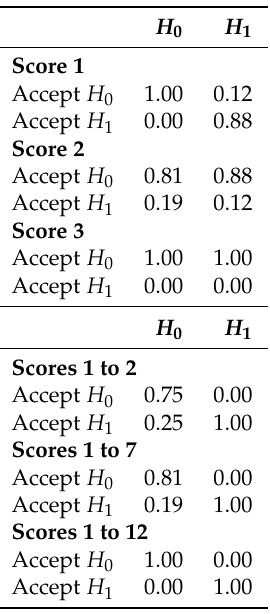
Table 7. Sensitivity and specificity of the test considering the first score, the second score, the third score (left); and scores 1 to 2 (jointly), scores 1 to 7 (jointly), and scores 1 to 12 (jointly) (right), when ν = 50 and α =